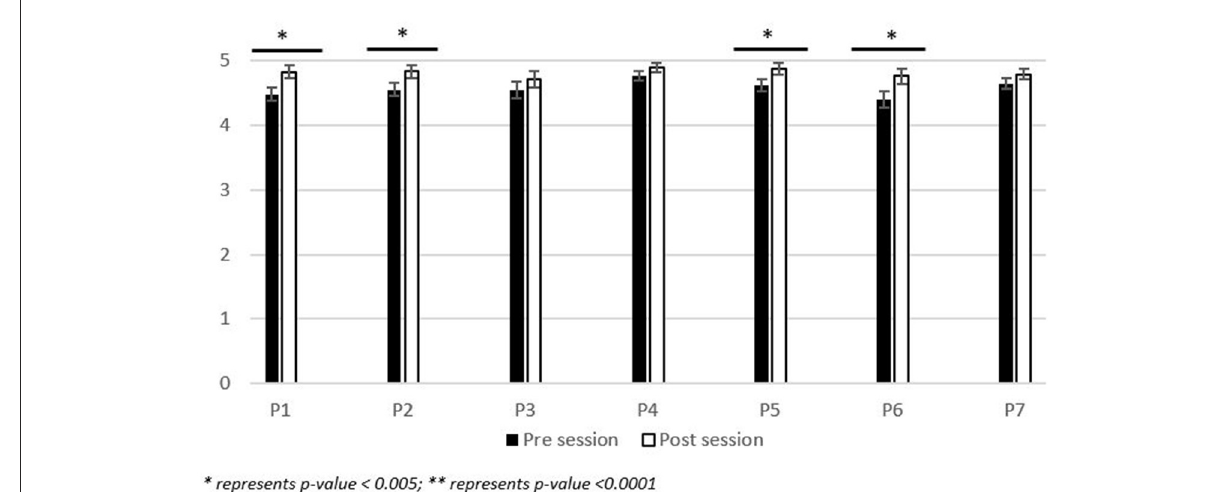
FIGURE2 Participant reported change in perception of the importance of LGBTQIA + topics. Range of significance of results of the pre-/post- activity survey responses ( n = 111) to the following prompts: (P1) How important is it for healthcare professional students to receive education about the primary care of Lesbian, Gay, Bisexual, and Transgender patients? (P2) How important is it for healthcare professional students to receive education about the primary care of Transgender patients? (P3) How important is it for a primary care provider to be able to provide information to (LGBTQIA + ) patients about local resources for (LGBTQIA + ) community engagement? (P4) How important is it for healthcare professional students to recognize increased health risks associated with sexual orientation? (P5) How important is it to engage in self-reflection processes to correct implicit biases regarding LGBTQIA + individuals? (P6) How important is it to implement gender-neutral practices in your clinical practice and clinic? (P7) How important is it to discuss safe sex practices with individual women who have sex with women? Participants responded on a 5-point Likert scale with 5, Extremely Important; 4, Somewhat Important; 3, Neutral; 2, Somewhat Unimportant; 1, Extremely Unimportant. Data is represented as the average response from the Likert scale + /– the standard error of the